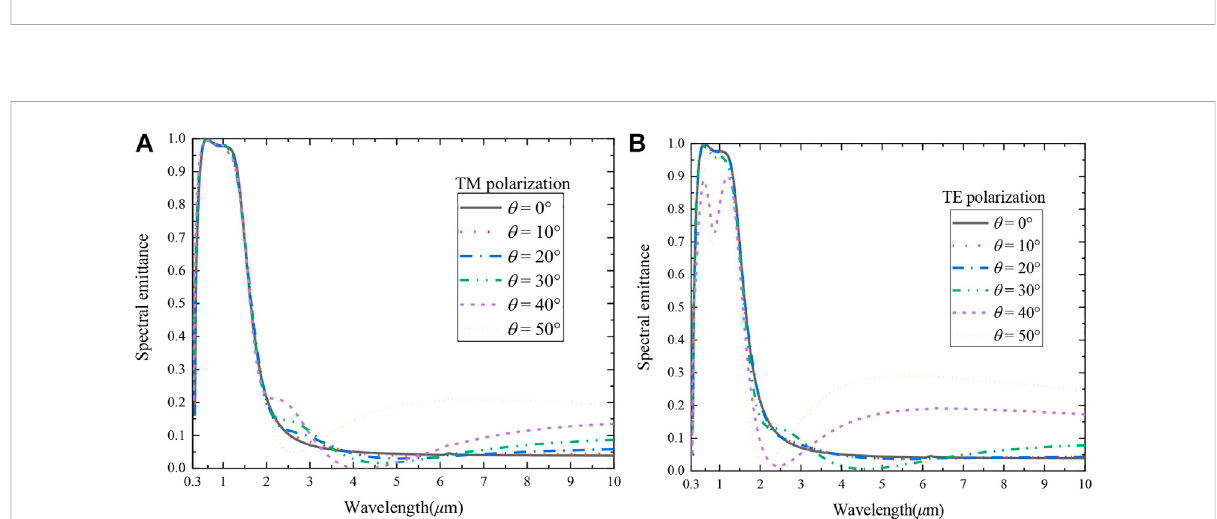
FIGURE 11 Variationofspectralemittancewithincidentangleforone-dimensionalstructures( LP =10, d M =10 nm, d D =80 nm)for (A) TMpolarizationand (B) TE polarization, respectively.